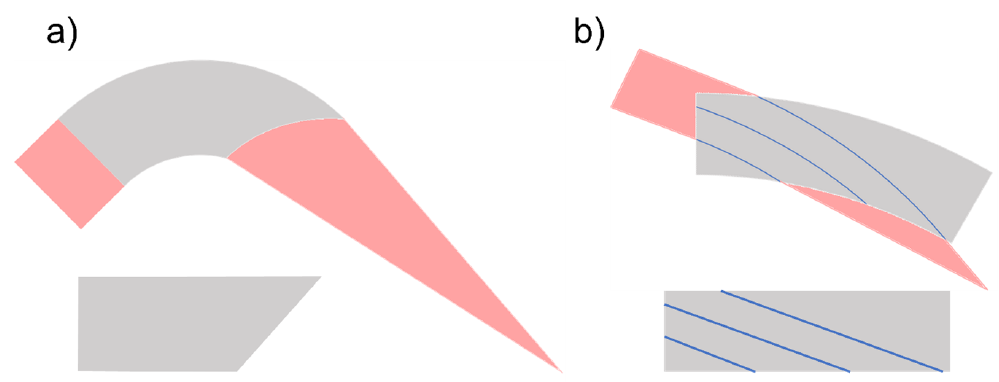
Figure 5. ( a ) Focus/defocus crystal, exploiting a machined wedge in order to modify the length of the crystal and consequently the channeling deflection angle in function of the impact parameter. ( b ) In this case, the different path is obtained by a careful selection of miscut angle between sample